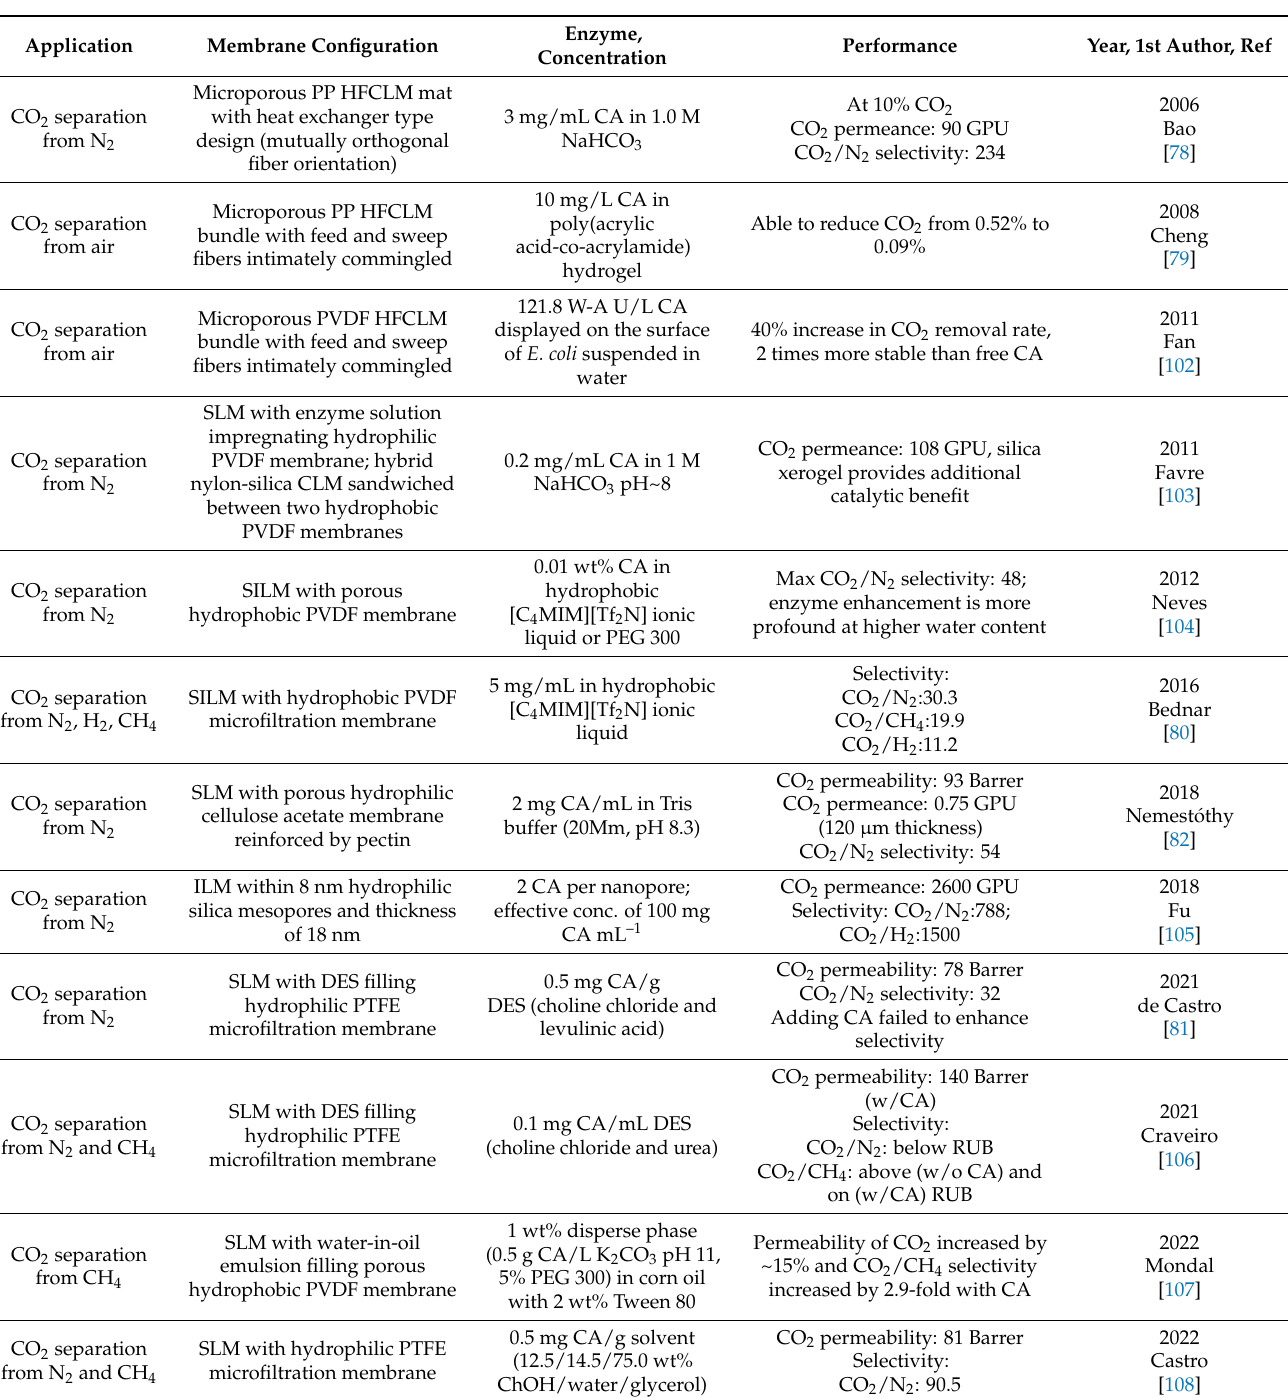
Table 2. Liquid membranes with carbonic anhydrase for CO 2